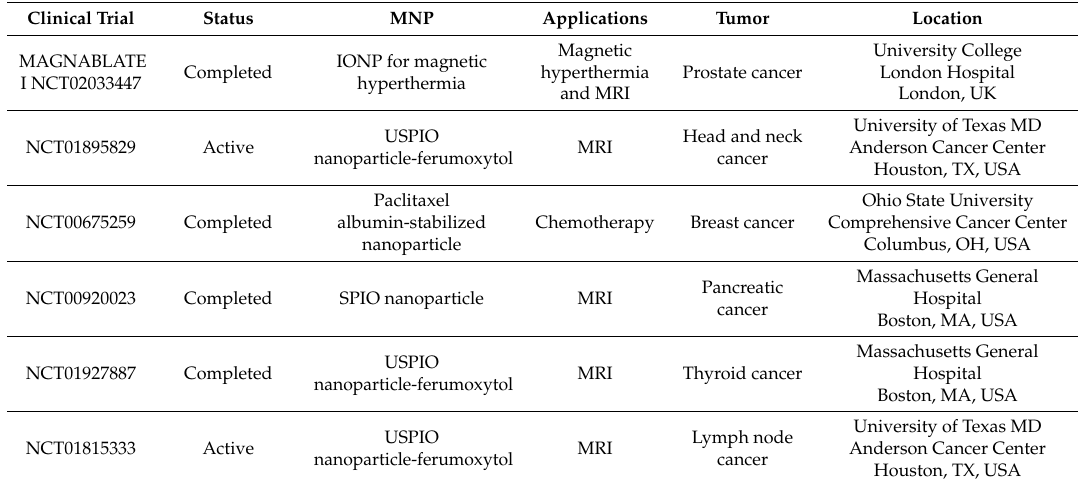
Table 4. List, not exhaustive, of clinical trials involving magnetic nanoparticles in cancer diagnosis and / or